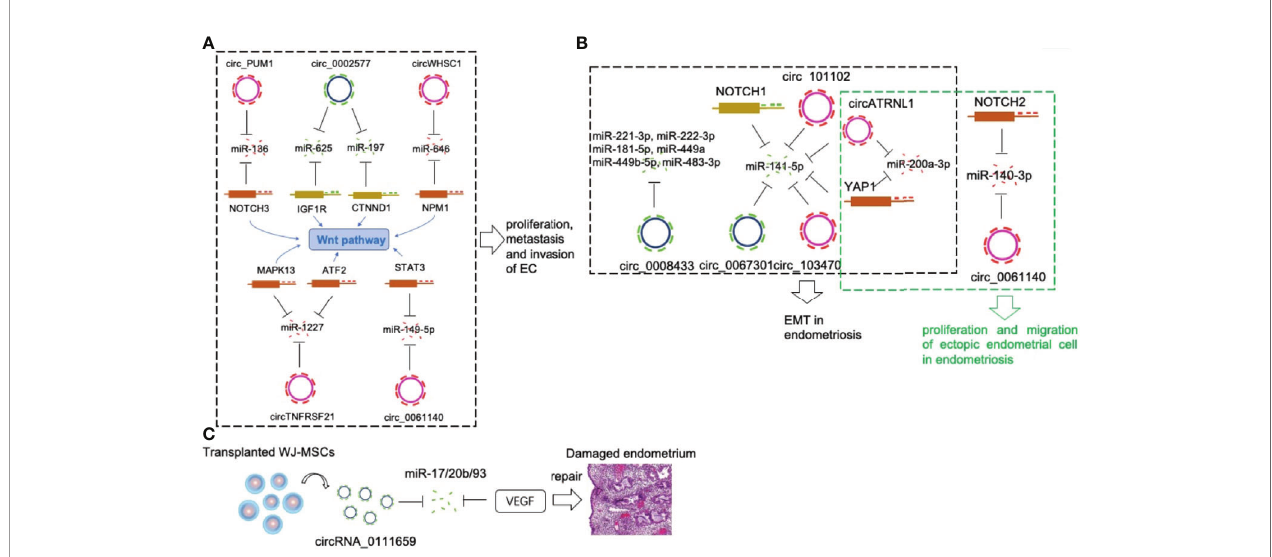
FIGURE 1 | CircRNAs in a pathological endometrium. (A) Circ_PUM1, circ_0002577, circWHSC1, circTNFRSF21 and circ_0061140 compete with NOTCH3, IGF1R, NPM, MAPK13/ATF2 and STAT3 via sponging miR-136, miR-625/miR-197, miR-646, miR-1227 and miR-149-5p respectively, to promote EC development. (B) The circ_0067301/miR-141e-5p/NOTCH1, circ_103470/miR-141-5p, circ_101102/miR-141-5p, circATRNL1/miR-141-5p/miR-200a-3p/YAP1, circ_0061140/ miR-140-3p/NOTCH2 axis played an important regulatory role in the EMT and proliferation/migration in endometriosis. (C) The circRNA_0111659-miR-17/20b/93- VEGF association is involved in regulating endometrial damage